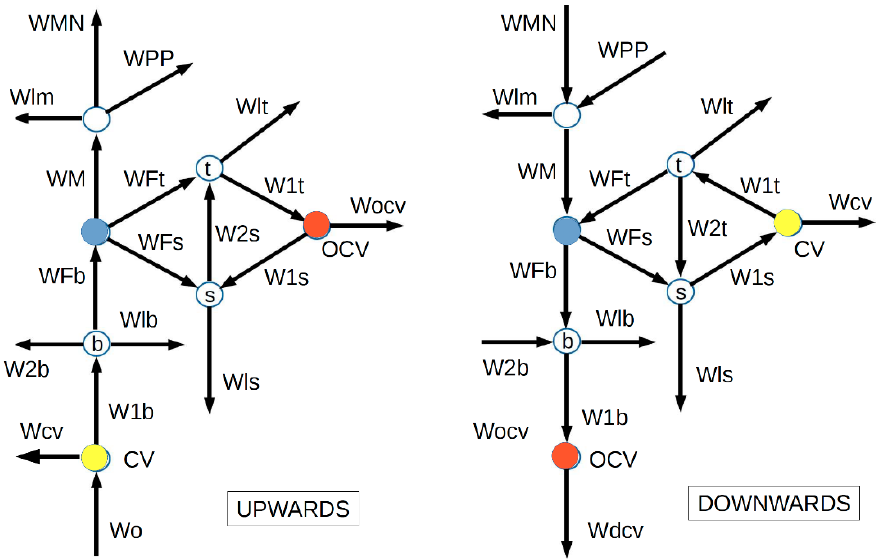
Figure 5. Energy Flow Diagrams through the different parts of the lifting system (up and down movements).